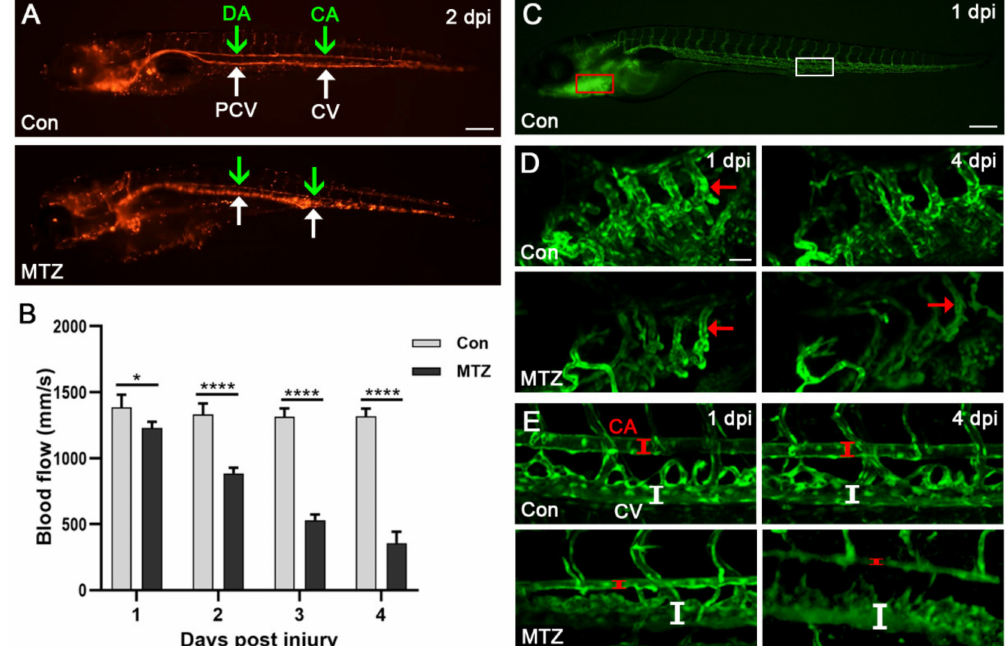
Figure 5. Changes of blood flow and blood vessels in ARF larvae. ( A ) The erythrocytes in the caudal artery (CA) (green arrow), caudal vein (CV) (white arrow), posterior cardinal vein (PCV) (green arrow) and dorsal aorta (DA) (white arrow) of Tg(cdh17:Dendra2-NTR; flk1:GFP;gata1:DsRed) zebrafish larvae treated with MTZ or control are shown. Scale bar: 200 µ m. ( B ) After treatment with MTZ, the caudal artery blood flow velocity of zebrafish larvae ( n = 5) was evaluated using ImageJ. ( C – E ) Confocal images of blood vessels around the heart and tail of Tg(cdh17:Dendra2-NTR; flk1:GFP;gata1:DsRed) zebrafish larvae treated with MTZ or control ( n = 5). The Scale bars of ( C ) and ( D , E ) are 100 µ m and 200 µ m, respectively. The red and white line segments represent the vessel lumen of zebrafish larvae. CA, caudal artery; CV, caudal vein. Mean ± SEM; * p < 0.05 and **** p < 0.001, ANOVA/Dunnett’s test compared with